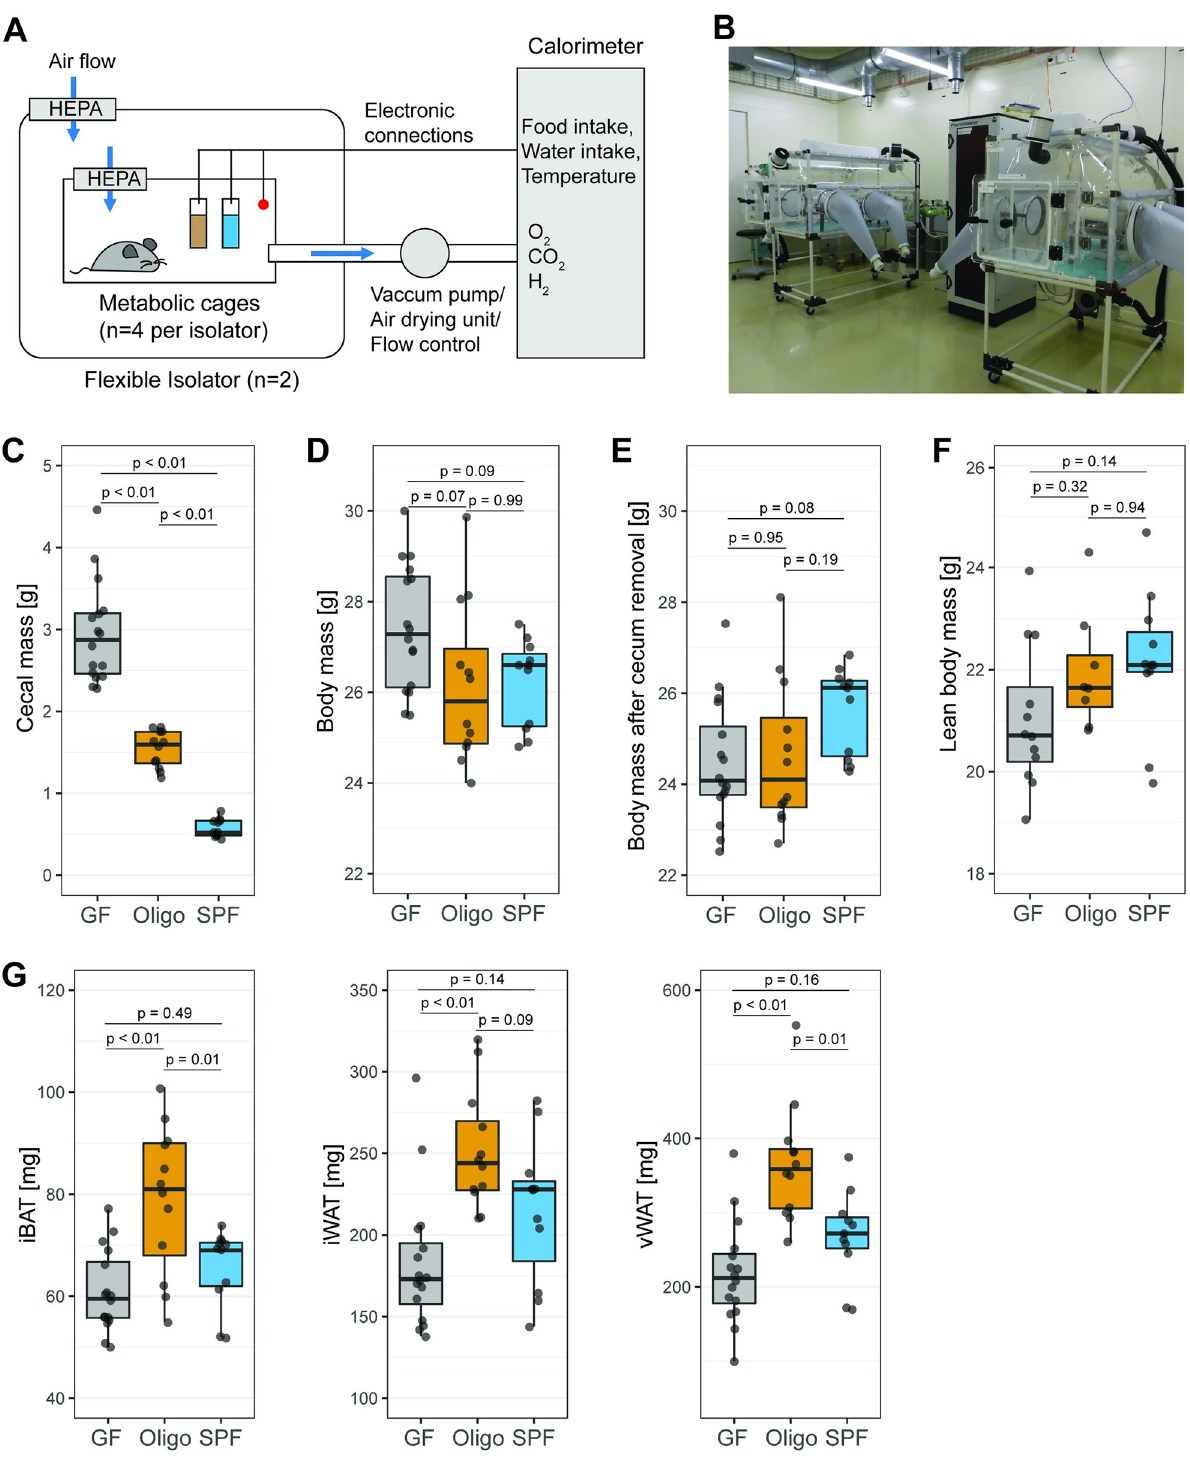
Fig 1. OligoMM12 mice have increased fat mass compared to GF mice and SPF C57B6/J mice. (A) Schematic representation of isolator-based indirect calorimetry system, with a TSE PhenoMaster calorimeter connected to 2 flexible surgical isolators with 4 metabolic cages each. (B) Pictures of isolator-based indirect calorimetry system inside the facility. (C) Cecal mass (tissue including luminal content). (D) Total body mass at the end of the experiment and before cecum removal. (E) Total body mass after cecum removal. (F) Lean body mass acquired by EchoMRI before cecum removal (N of mice per group with EchoMRI and indirect calorimetry measurements: GF = 12, OligoMM12 = 8, SPF = 11). (G) Fat mass from iBAT, iWAT, and